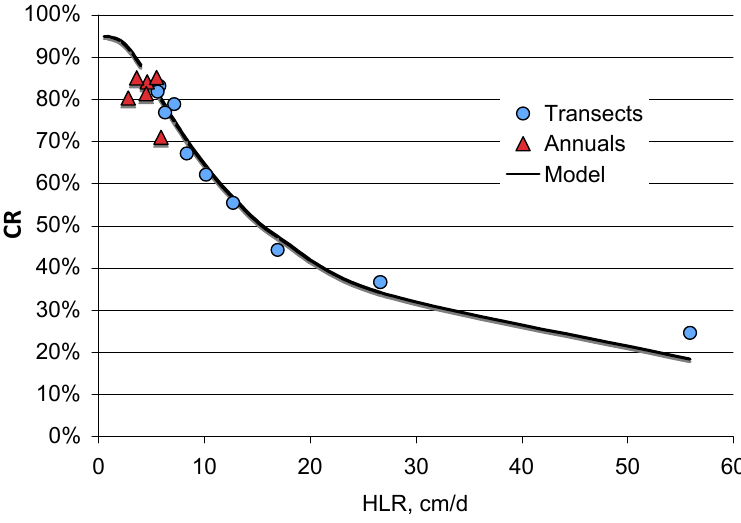
Figure 16. Transect data and the kC* model for 28 grid transects for STA2C3 taken over five years. The data were flow-weighted. The hydraulic loading rates decrease as the location moves along the transect from inflow to outflow. Shown for comparison are the annual input/output flow-weighted concentration reductions for the five-year period. The model parameters are: K = 44.4 m/year, and C* = 6 μ g/L, as co-determined by nonlinear regression. R 2 = 0.977.